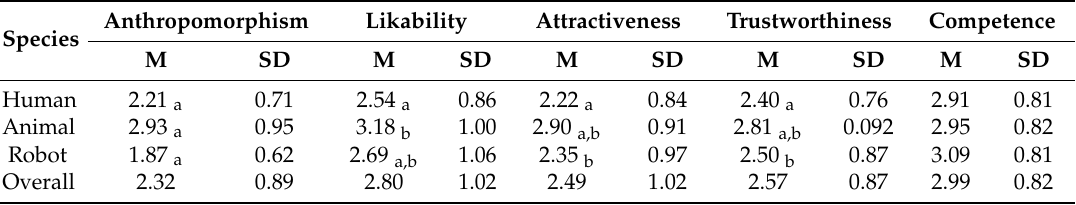
Table 8. Means of person perception for